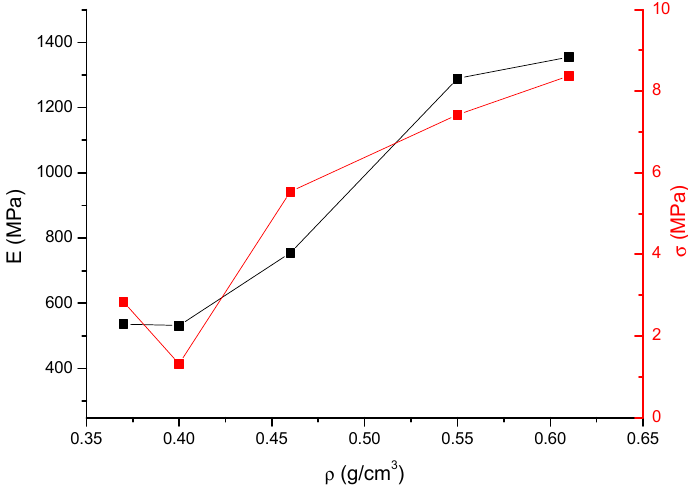
Figure 8. Elastic modulus and compression strength in function of density .